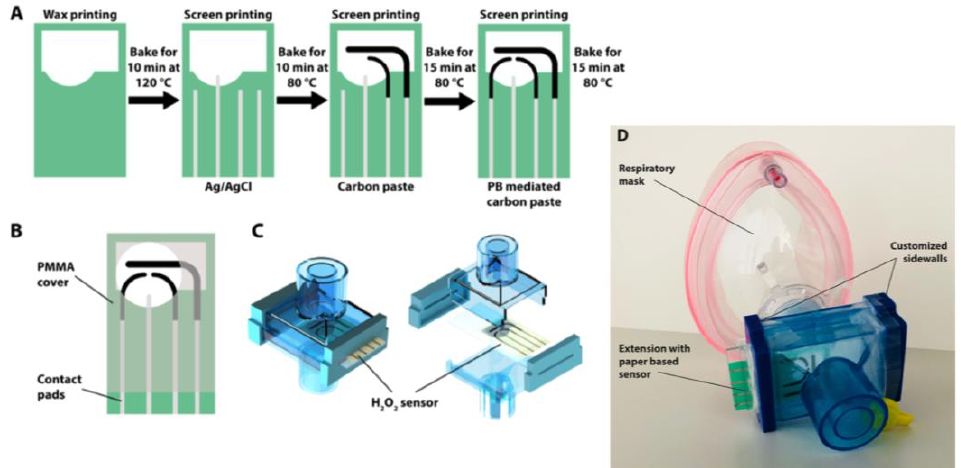
Figure 2. ( A ) Schematics of fabrication steps and ( B ) computer-aided design (CAD) drawing of the disposable cellulose paper-based electrochemical sensor for on-site testing of H 2 O 2 in exhaled breath with poly-methylmethacrylate (PMMA) carrier. ( C ) Model of a filter extension for respiratory mask. ( D ) Image of respiratory mask with the commercial filter extension with customized sidewalls, containingthesensorchip.